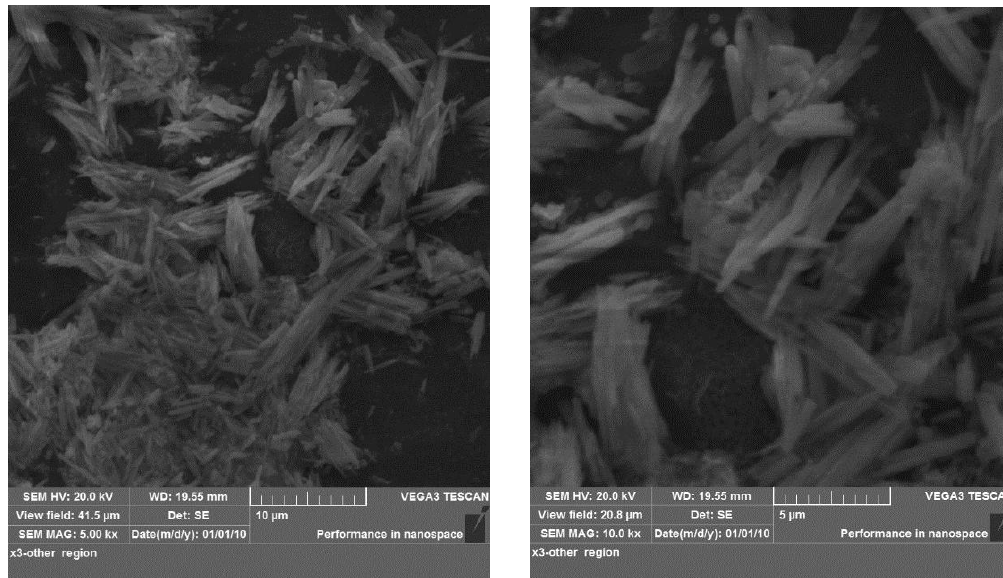
Fig. 4: SEM micrograph image for the S1 sample.